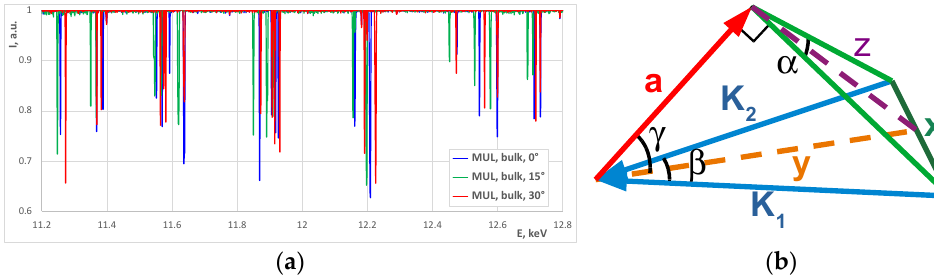
Figure 5. ( a ) Three measured glitch spectra at χ = 0°, χ = 15° and χ = 30°; ( b ) schematics of the determination of the rotation axis a from two known vectors K 1 and K 2